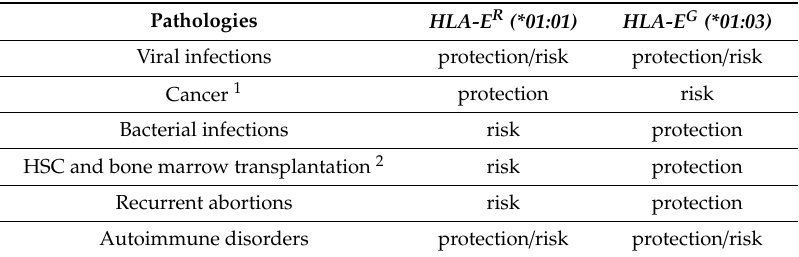
Table 2. The role of HLA-E alleles, *01:01 and *01:03 , in di ff erent